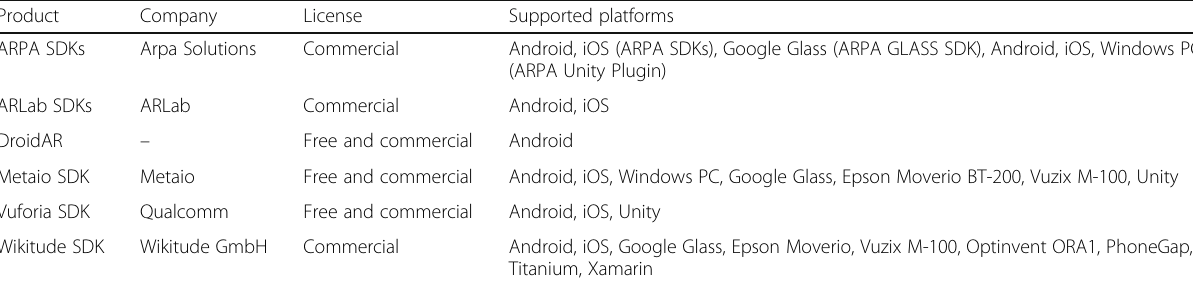
Table 2 AR game development tools [26]